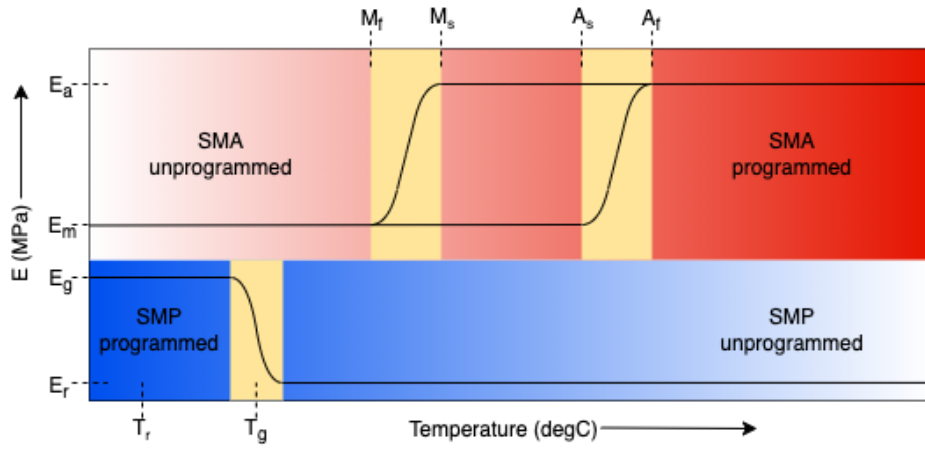
Figure 1. Complementary behaviour of the SMA and SMP dictating the periodic actuation obtained from the variation in stiffness with respect to temperatures (not to scale). Based on [19].